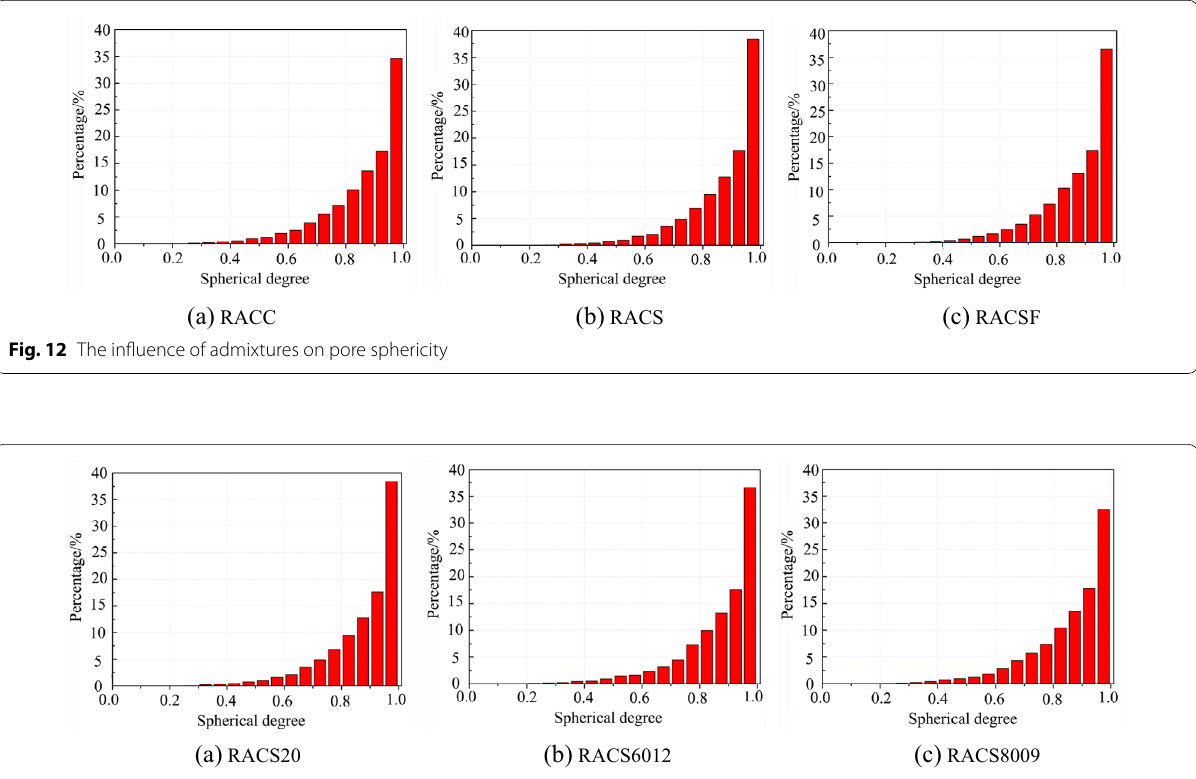
Fig. 13 Influence of curing condition on pore sphericity